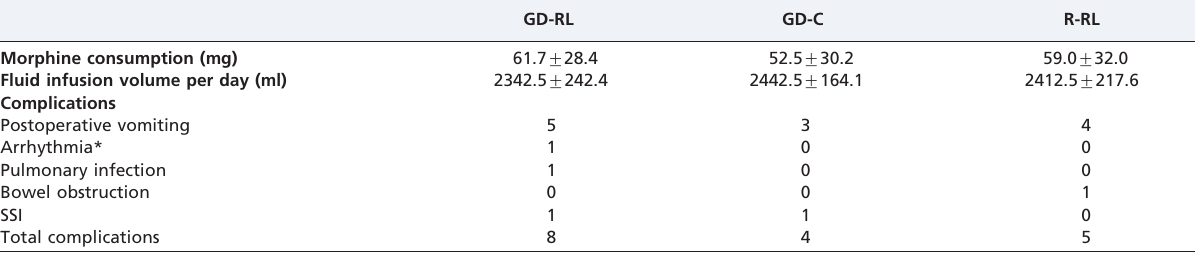
Table 3 - Postoperative data (n= 20).